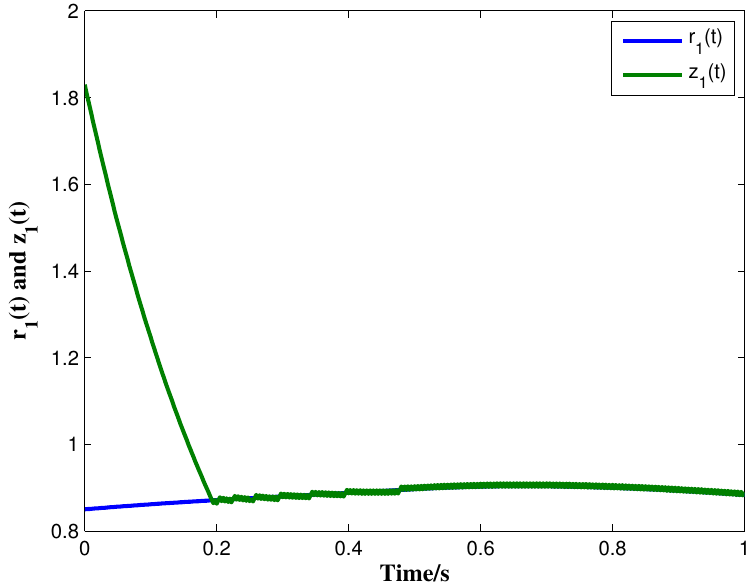
Figure 2. State trajectories of r 1 ( t ) and z 1 ( t ) with controller and ETC.